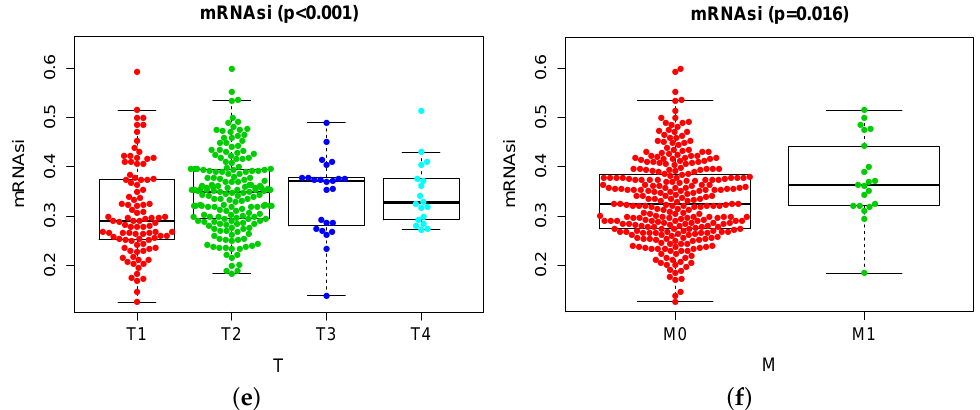
Figure 3. The correlation of global mRNAsi profiles with LUAD subtypes. ( a ) the scatter plot shows that the mRNAsi index expression in 404 tumor cases is higher than that in 40 normal cases ( p -value < 0.001); ( b ) the LUAD cases were divided into two groups based on their mRNAsi scores: the top half of 225 cases with higher mRNAsi scores and the bottom half of 226 cases with lower mRNAsi scores. The Kaplan–Meier survival curve shows that the median survival of the low score group is longer in the first five years. Few of both groups survived more than five years, but the high group enjoyed a higher survival probability. However, it is not statistically different as a whole, by the Log-rank test p -value = 0.425; ( c ) the distribution of mRNAsi scores for genders of LUAD cases. The box-plot shows that there is a significant association between gender and mRNAsi scores; mRNAsi expression is higher in male cases than female ( n = 404, p -value < 0.001); ( d ) the distribution of the mRNAsi index for the clinical stage of LUAD cases. The mRNAsi scores increase in more advanced clinical stages, and extremely so in stageIV ( p -value = 0.015). ( e , f ) The distribution of the mRNAsi index for the TNM degree of LUAD cases; few unknown cases were deleted out. The mRNAsi score increases in T1–T3 degree and declines in T4 ( p -value < 0.001); group of M1 degree have a higher mRNAsi score than M0 ( p -value =